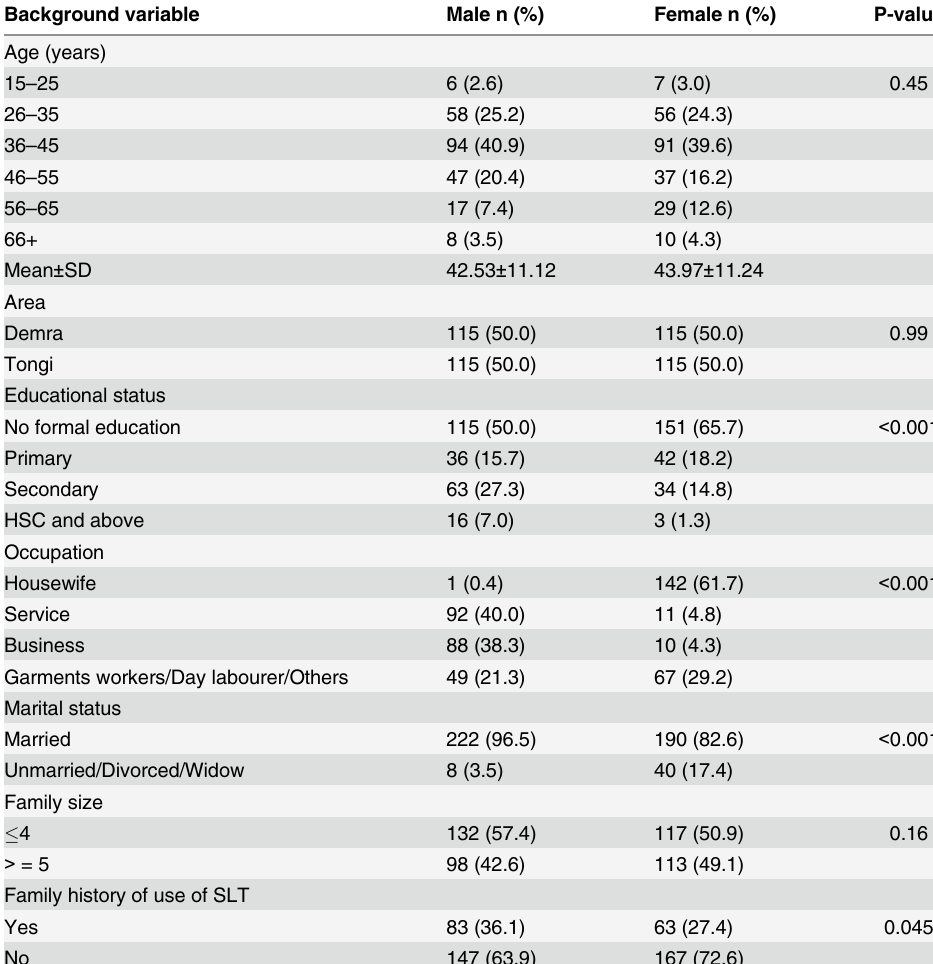
Table 1. Socio-demographic features of survey